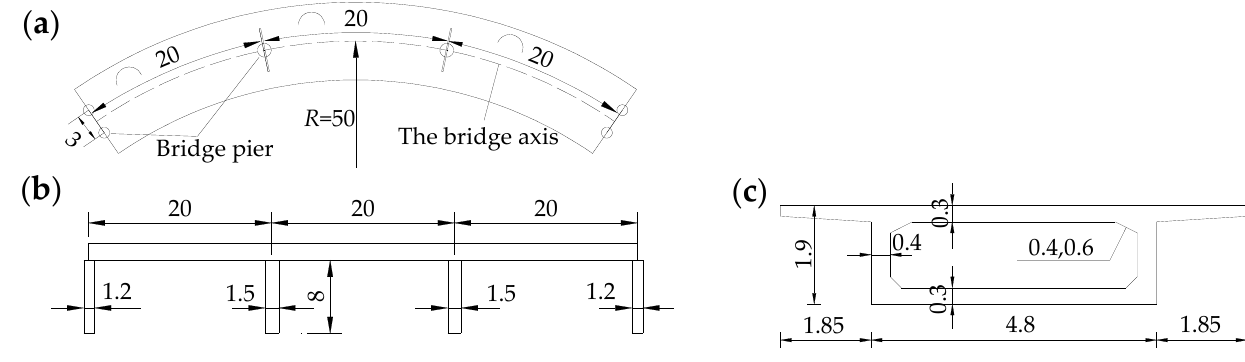
8 of 28 Figure 1. Flowchart of seismic damage identification for CCRFBs.